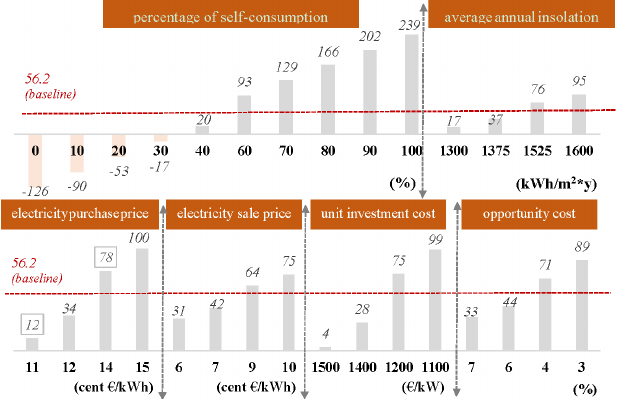
Figure 2. Sensitivity analysis–NPV (k€) for a 200 kW power system. NPV: net present value.